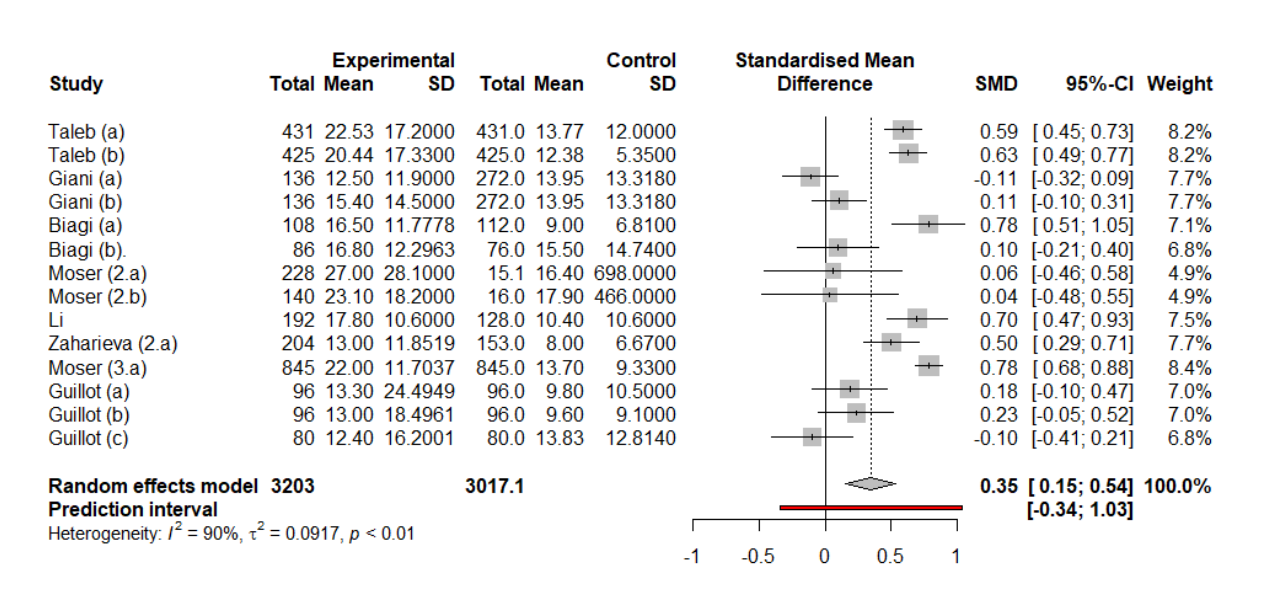
Figure 4. Meta-analysis using the random effects model, including the corresponding forest plot. The above-mentioned outliers were excluded. SMD stands for Standardised Mean